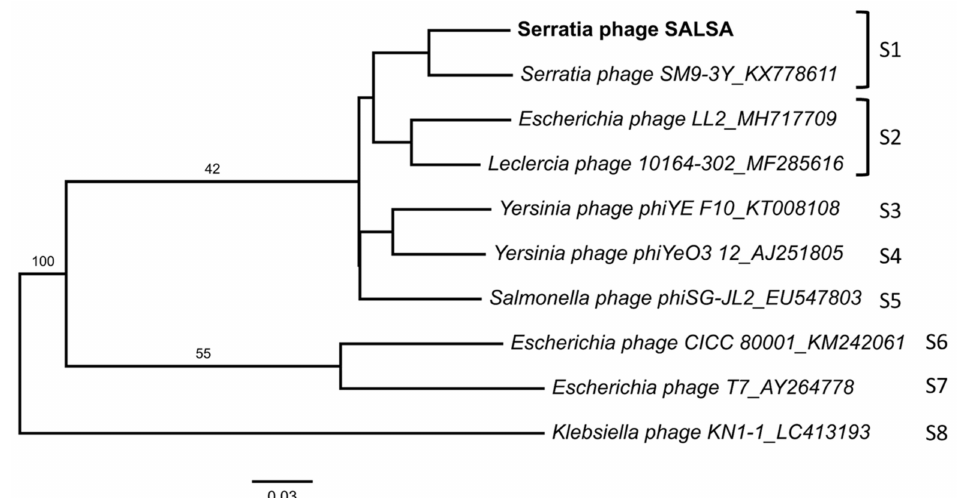
Figure 2. Whole genome-based phylogenomic treeing analysis, based on the Genome-BLAST Distance Phylogeny method (GBDP), is referred using the formula D6. The numbers above branches are GBDP pseudo-bootstrap support values from 100 replications. The branch lengths of the resulting VICTOR trees are scaled in terms of the respective distance formula used. The OPTSIL clustering yielded eight species clusters (S1 to